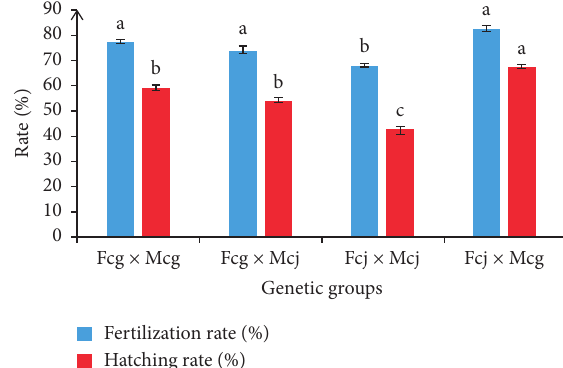
Figure 2: Fertilization and hatching rates in reciprocal hybrid- izations of Clarias gariepinus × Clarias jaensis in controlled con- ditions. a, b, c: bars of the same color with the same letters are not significantly different ( p > 0 . 05). The female was named first.